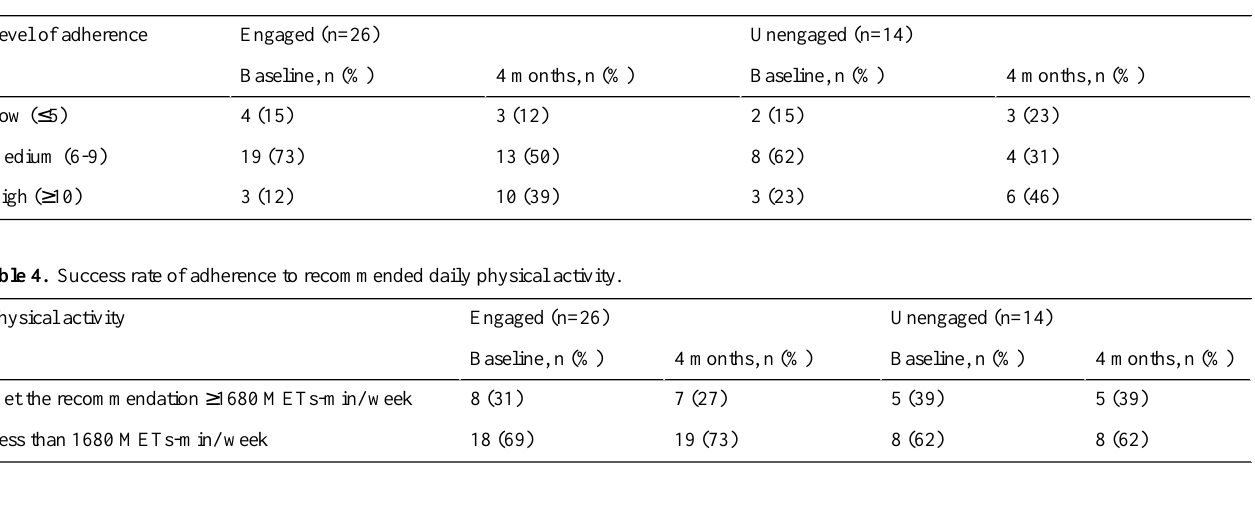
Table 3. Adherence to Mediterranean diet score.